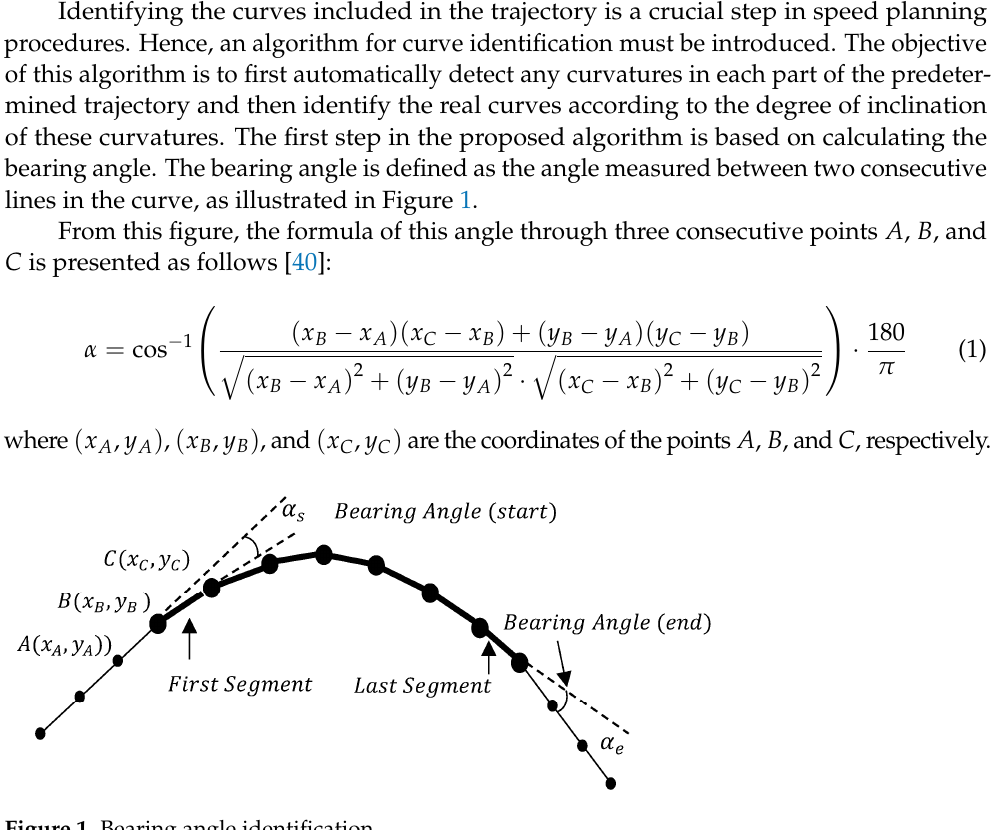
Figure 1. Bearing angle